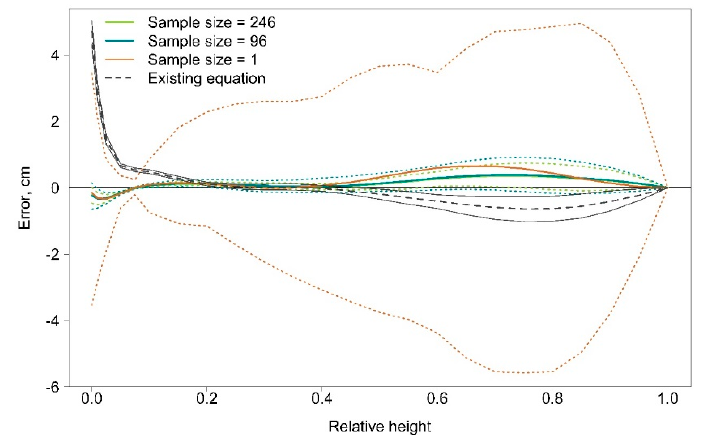
Figure 9. Errors in estimated taper curves based on parametrized equation using all (green) as well as randomly selected 96 (blue) and one (brown) Scots pines for modelling. Additionally, di ff erence in taper curve based on the coe ffi cients by Laasasenaho (1982) (i.e., existing equation, black dashed line). Minimum and maximum errors in estimated taper curves are shown of corresponding color in dotted lines, except for existing model in solid lines.